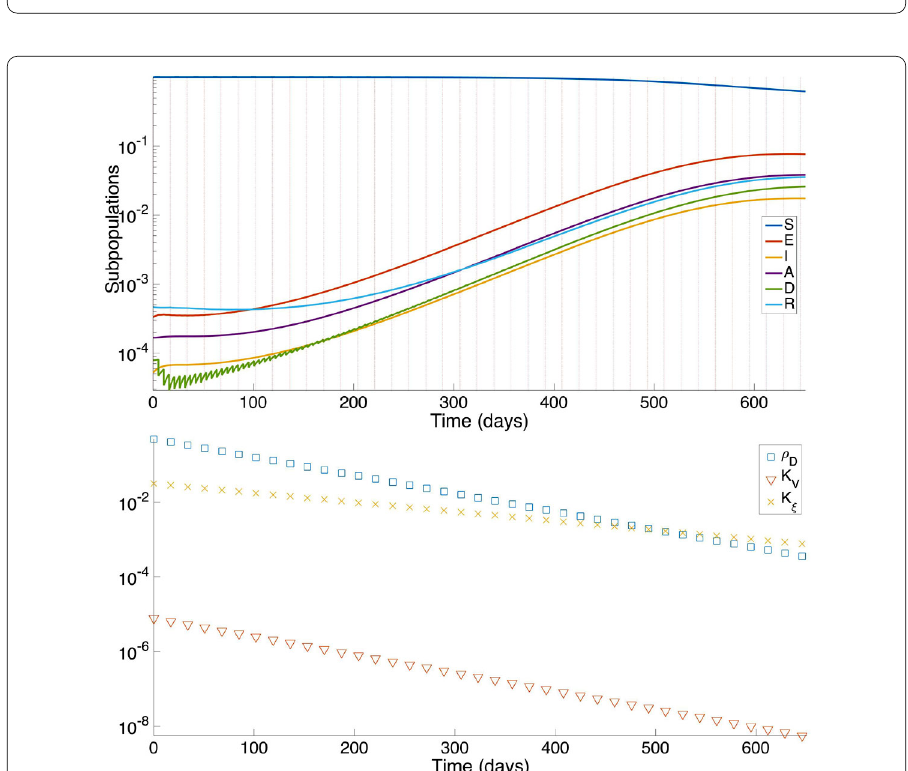
Figure 7 ( a ) Dynamics of the subpopulations through time; ( b ) values of the parameters of the control strategy through time